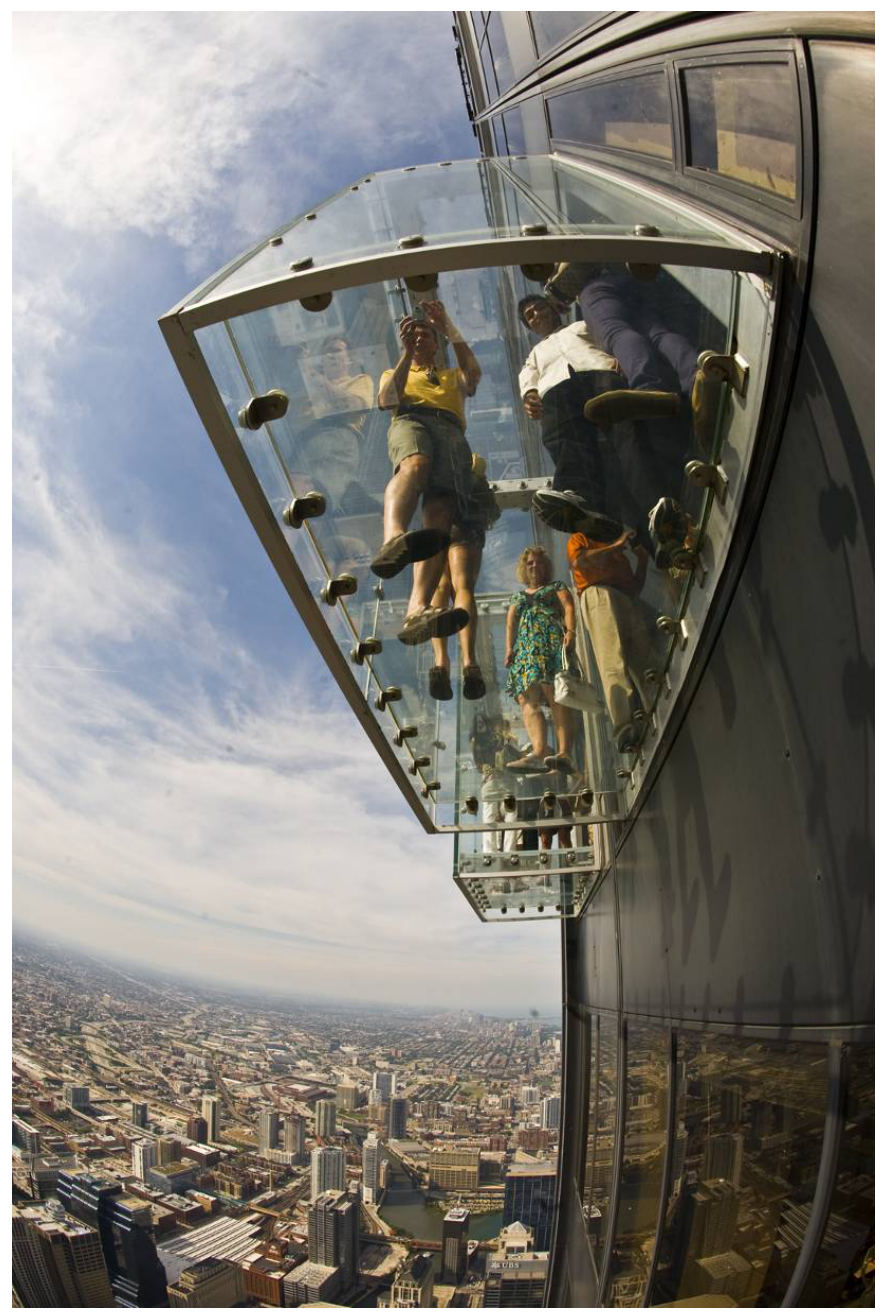
Figure 10: The glass observation boxes as viewed from below.